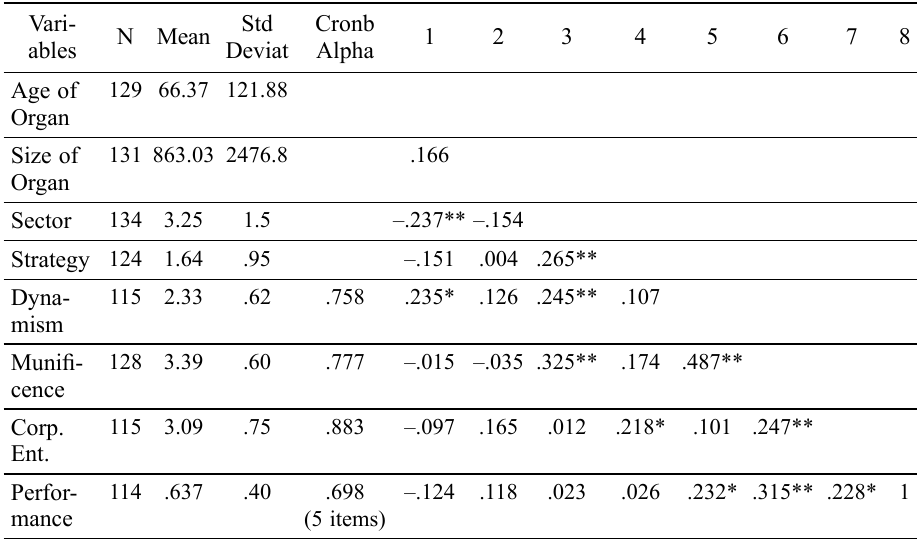
Table 4. Summary descriptive statistics, reliabilities and correlation